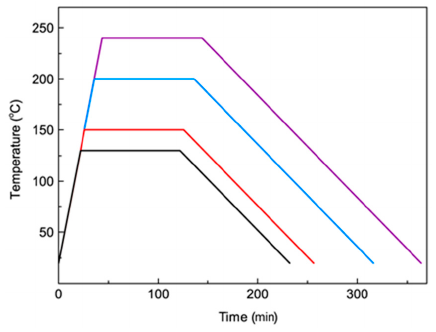
Figure 3. Heat treatment conditions of 3D-printed PPS samples.